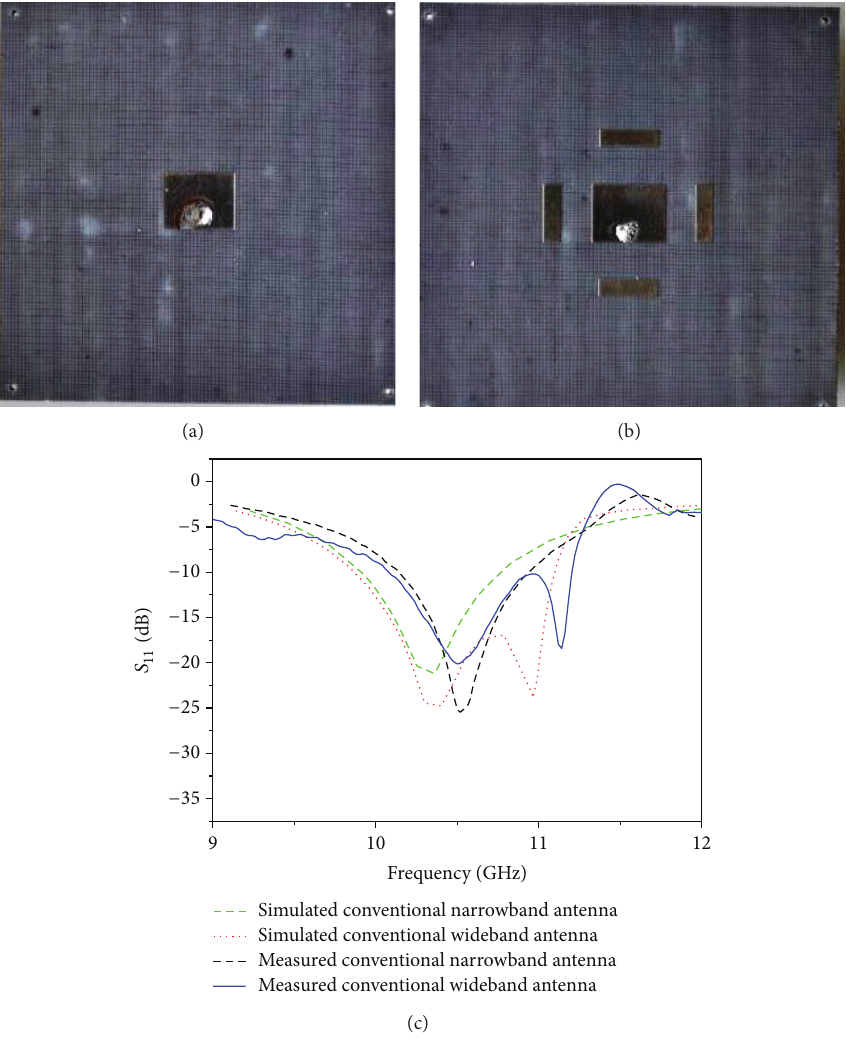
Figure 3: The conventional patch antennas, (a) the prototype of the conventional narrowband antenna, (b) the prototype of the conventional wideband antenna, and (c) the reflection coefficients.